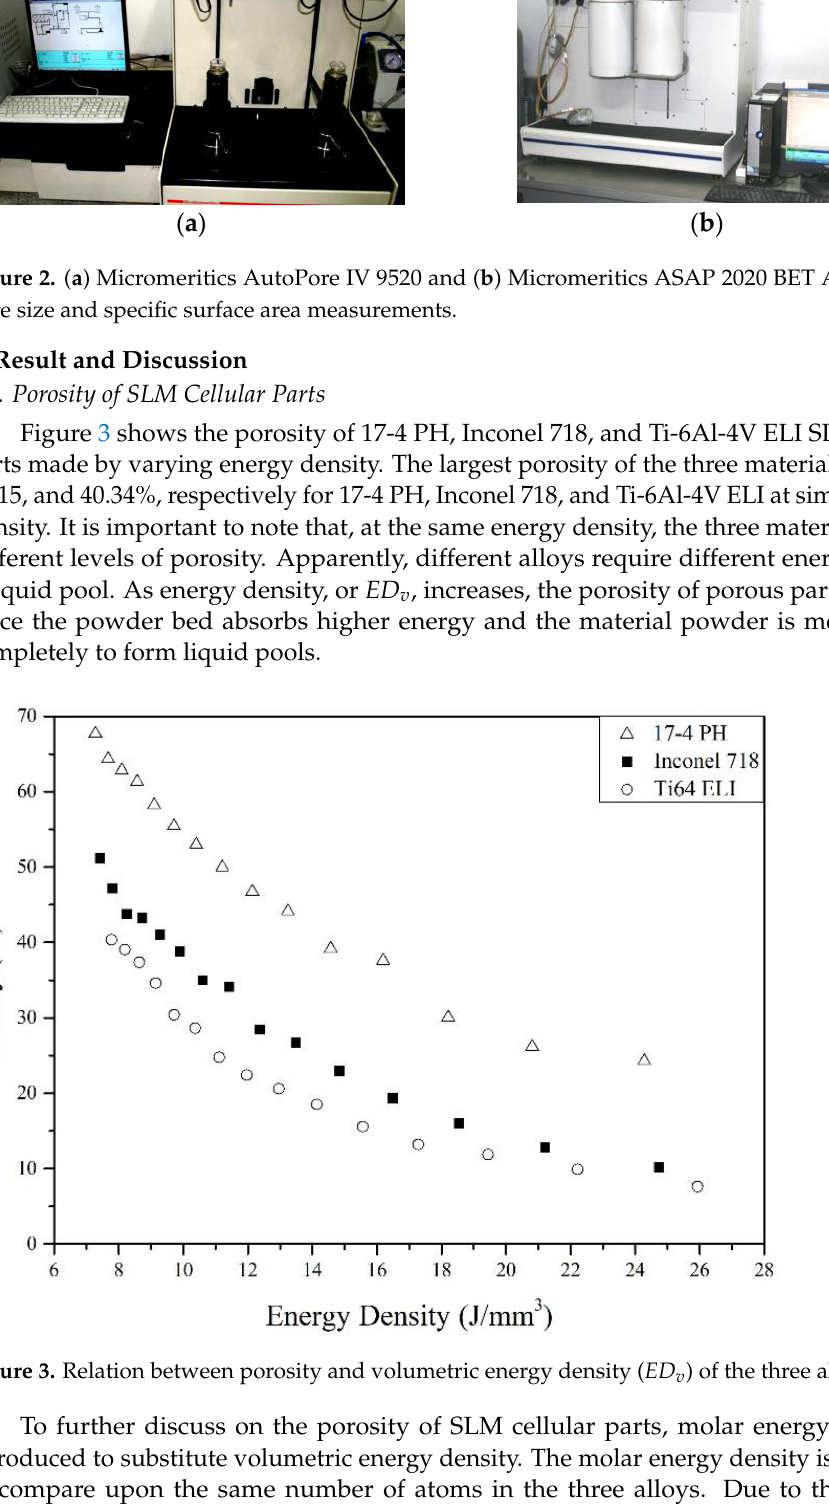
Table 3. Theoretical density and molecular weight of 17-4 PH, Inconel 718 and Ti-6Al-4V ELI. Material